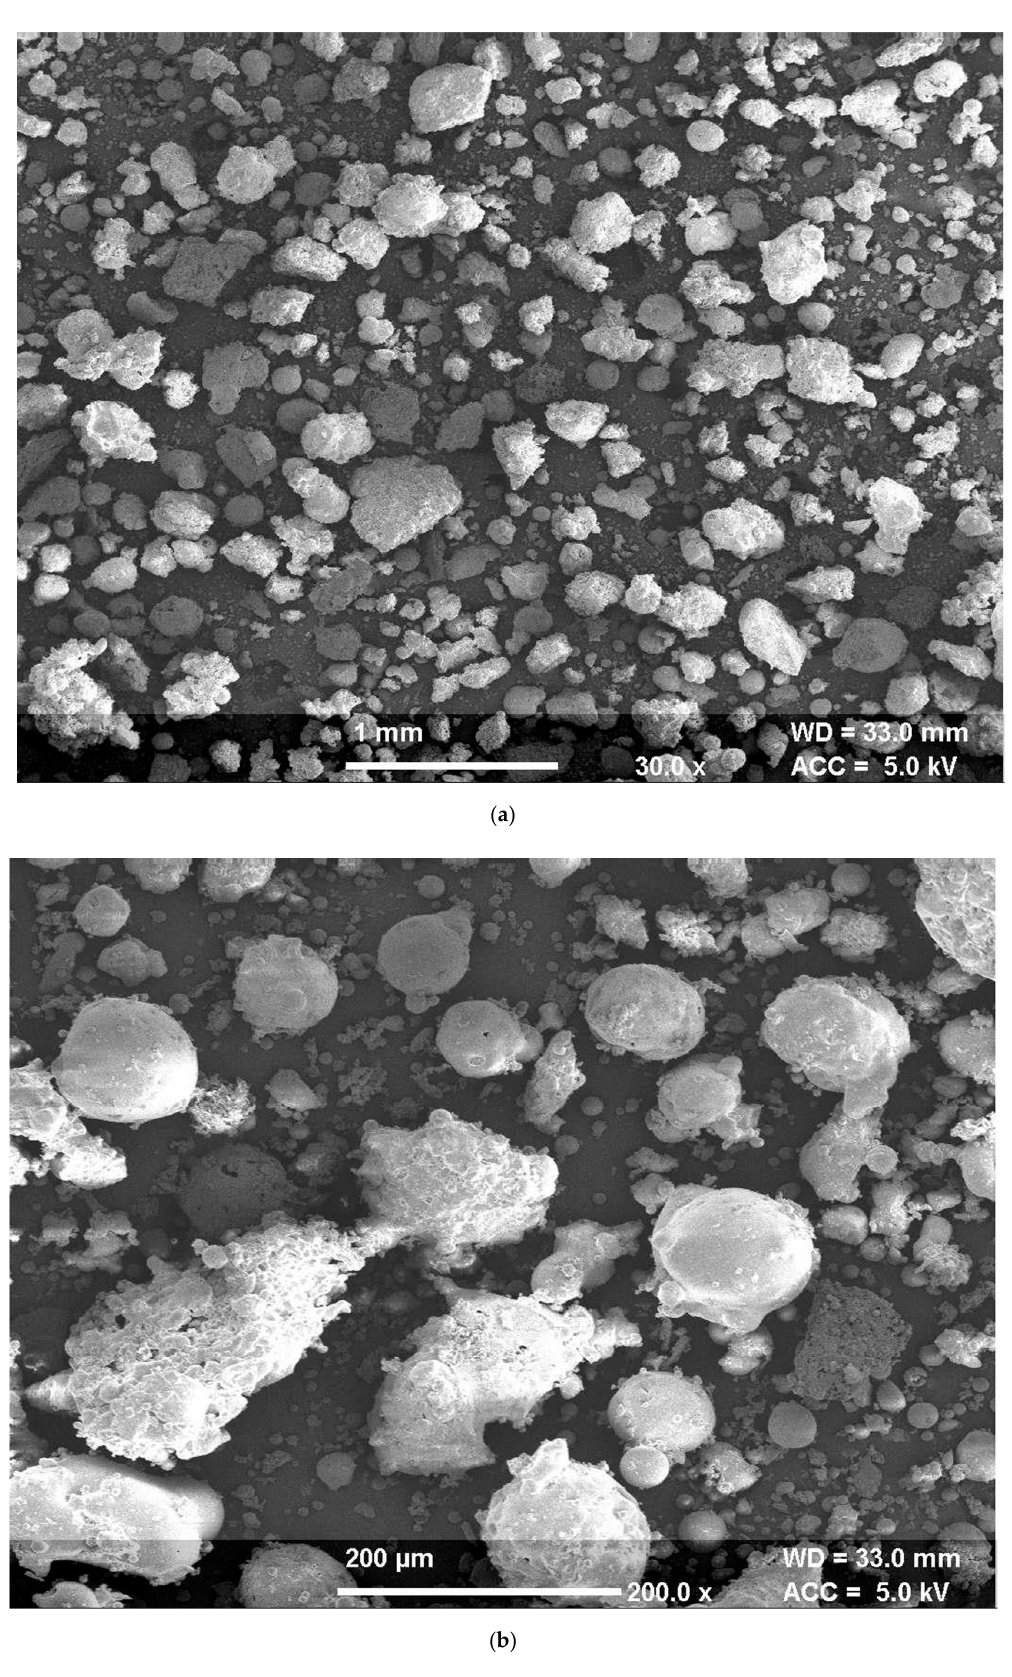
Figure 4. ( a ): SEM micrographs for pond ash at magnification 30 × ; ( b ): SEM micrographs for pond ash at magnification 200 ×